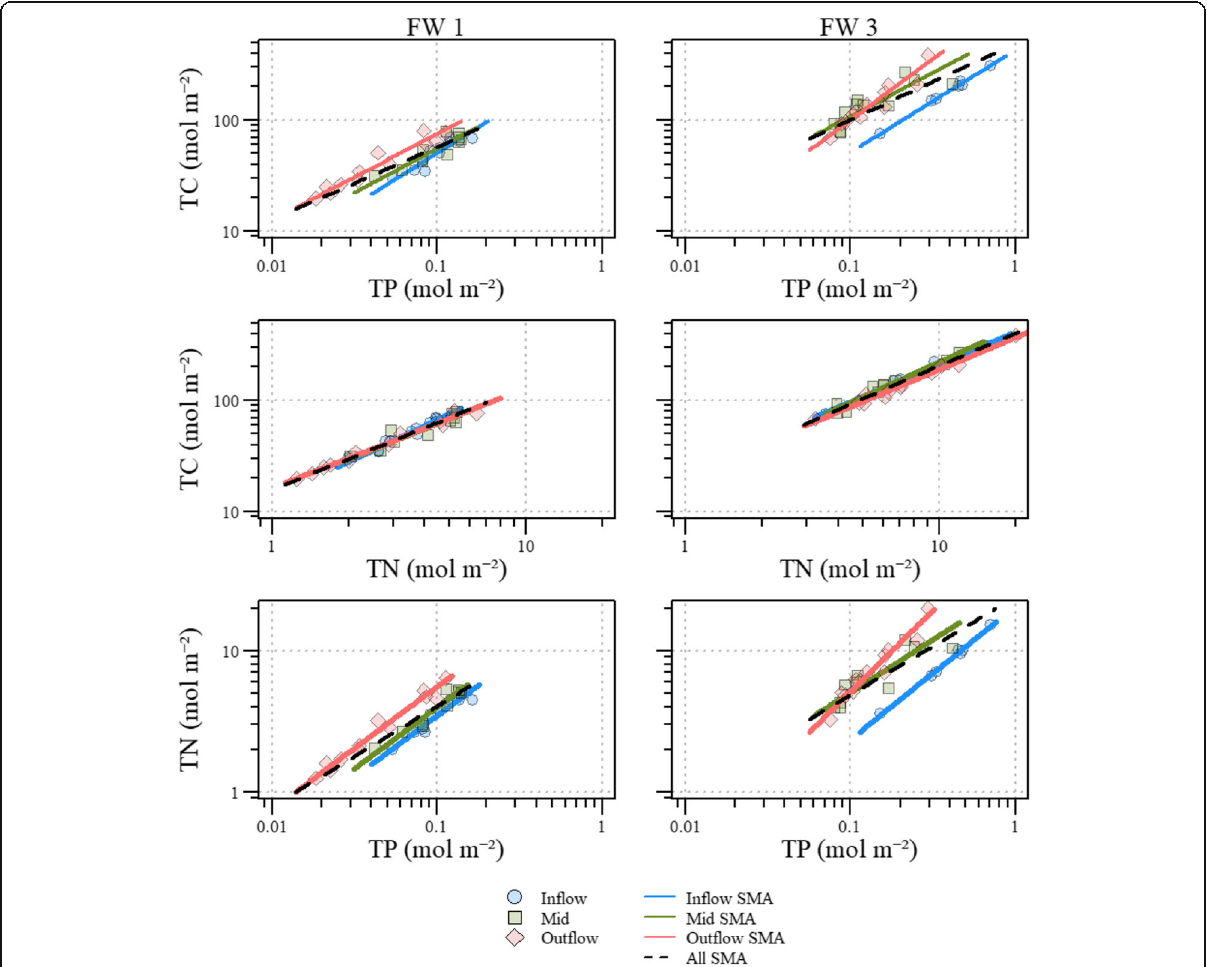
Fig. 4 Stoichiometric relationships between total carbon (TC), total phosphorus (TP), and total nitrogen (TN) in the floc ecosystem compartment for Stormwater Treatment Area 2, flow-ways (FWs) 1 and 3. Inflow, mid, outflow, and overall standardized major axis (SMA) regressions are indicated by lines through the data. Values can be converted to mass per volume (i.e., milligram per kilogram) concentration by multiplying each value by its respective conversion factor (C = 12.01; N = 14.00; P =